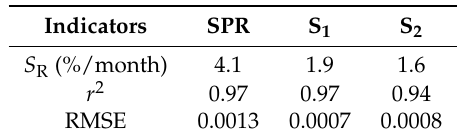
Table 1. Soiling rates and respective statistical